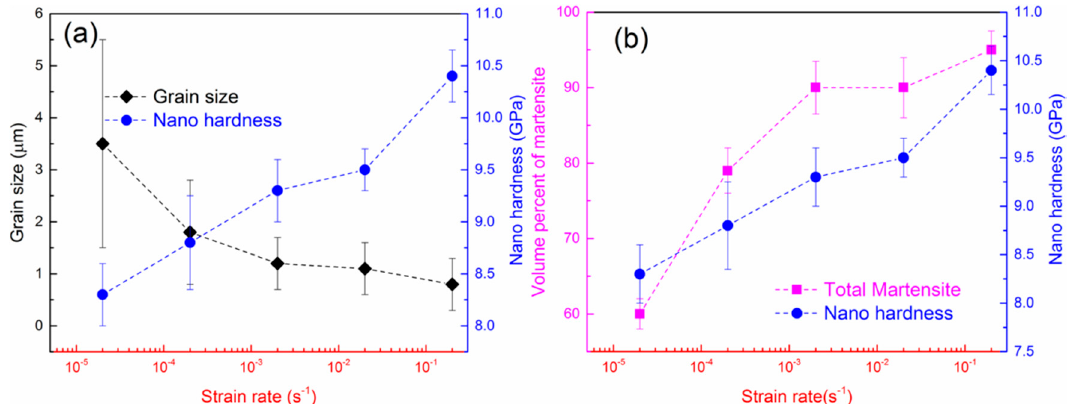
Figure 5. ( a ) Grain size profile and nanohardness under compression stress at various strain rates; ( b ) The volume percent of martensite and nanohardness profile under compressive stress at different strain rates.